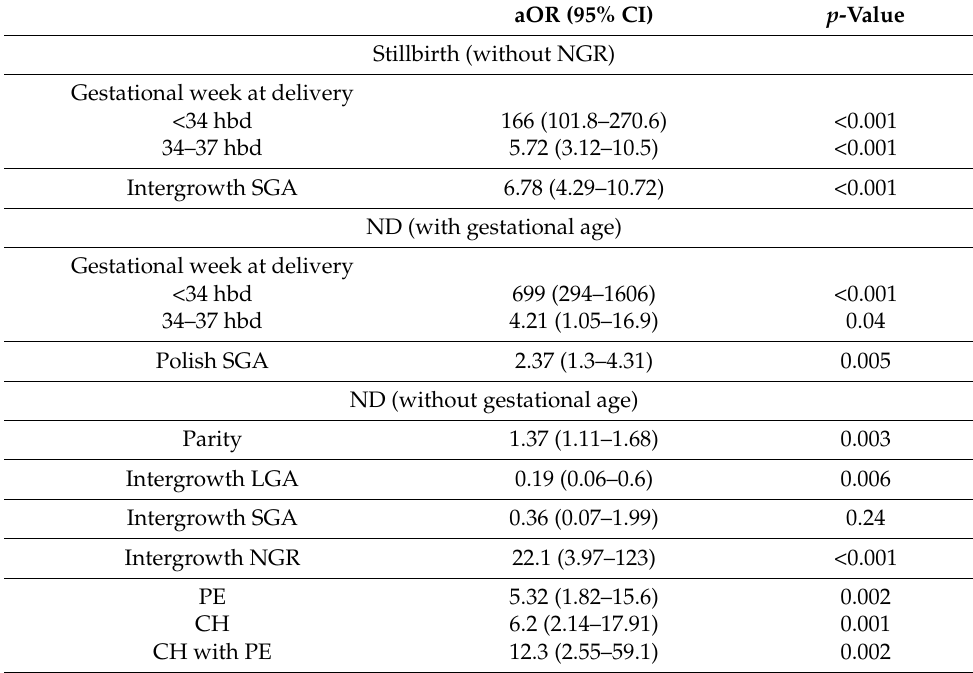
Table 5. Multivariate logistic regression for neonatal